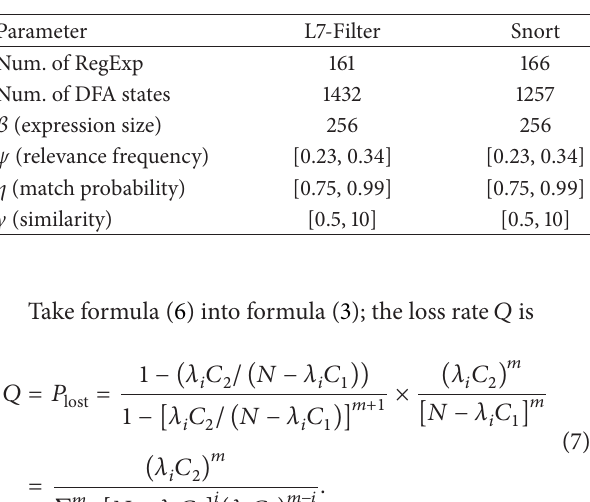
Table 1: Experimental parameters setting.